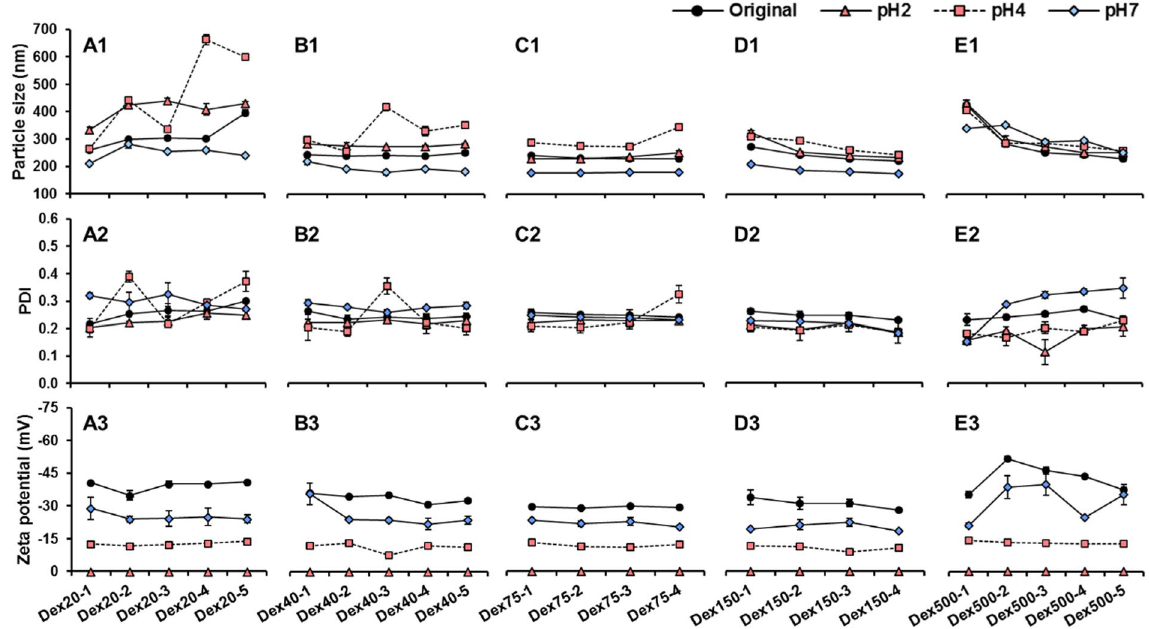
Figure 6. Particle size (A1-E1), PDI (A2-E2), and zeta potential (A3-E3) of LPN in simulated gastrointestinal conditions (pH2, pH4, and